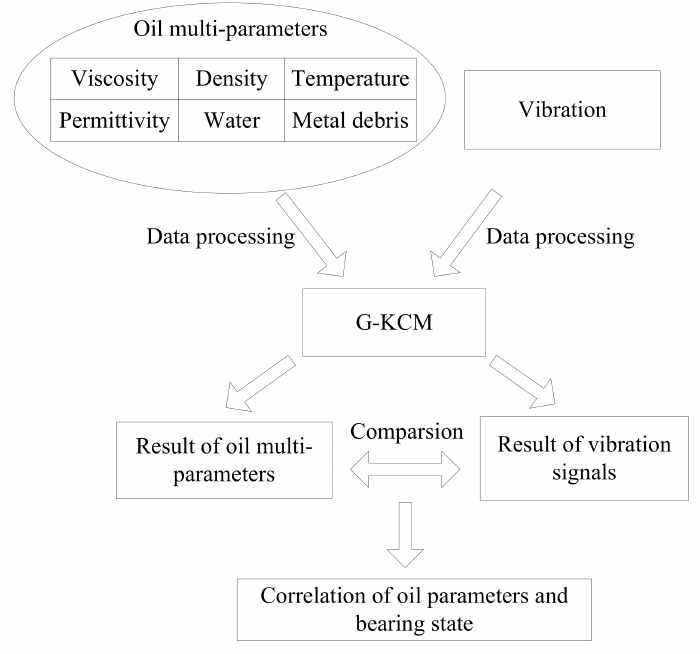
Figure 5. The implementation route of bearing states